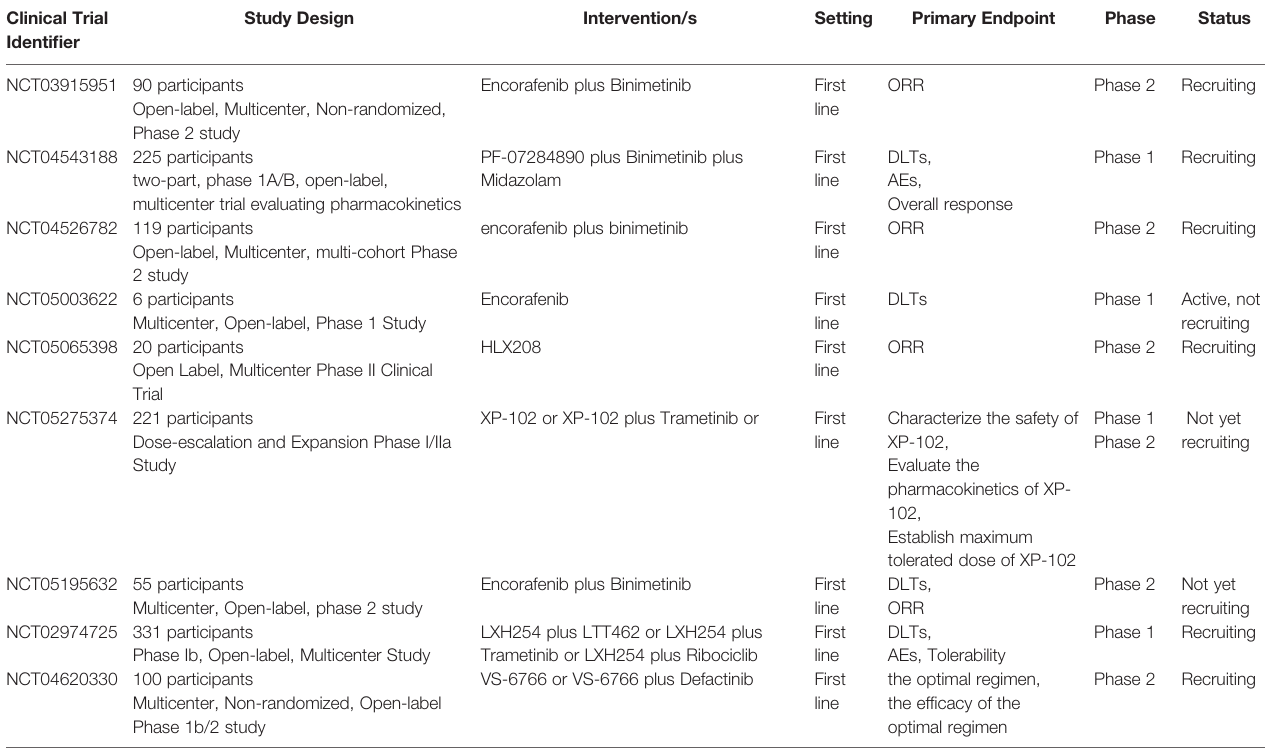
TABLE 3 | Selected ongoing trials with BRAF Inhibitors for NSCLC.